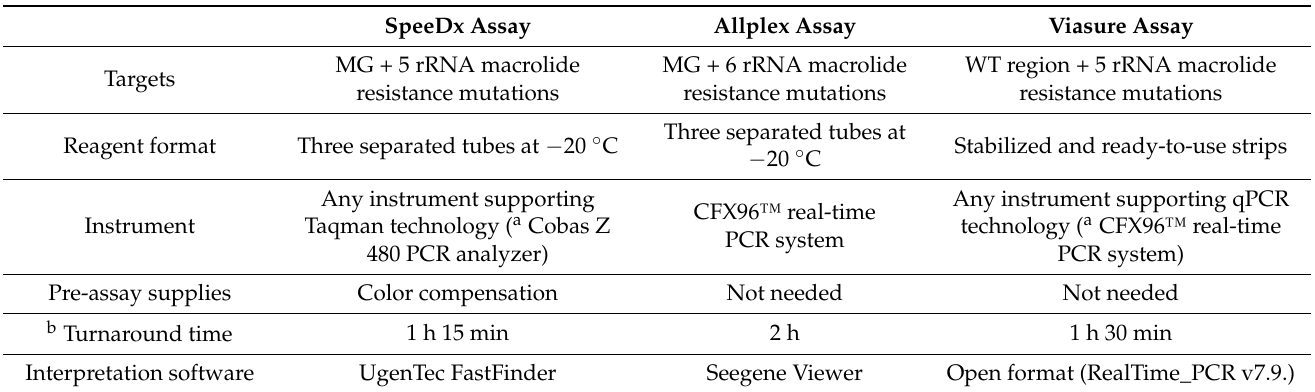
Table 4. Main characteristics of the three assays under study, ResistancePlus ® MG panel kit (SpeeDx assay), Allplex TM MG & AziR Assay (Allplex assay), and VIASURE macrolide resistance-associated mutations (23SrRNA) Real time PCR detection kit (Viasure